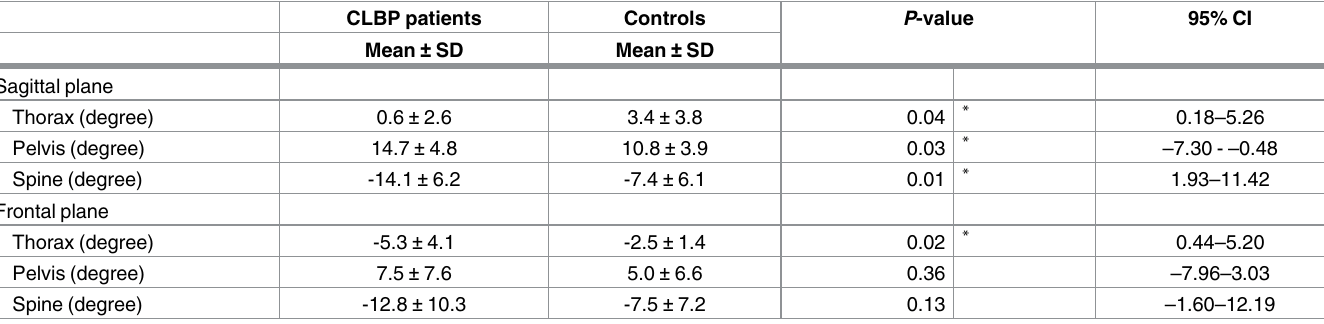
Table 4. Coupled motion in sagittal and frontal